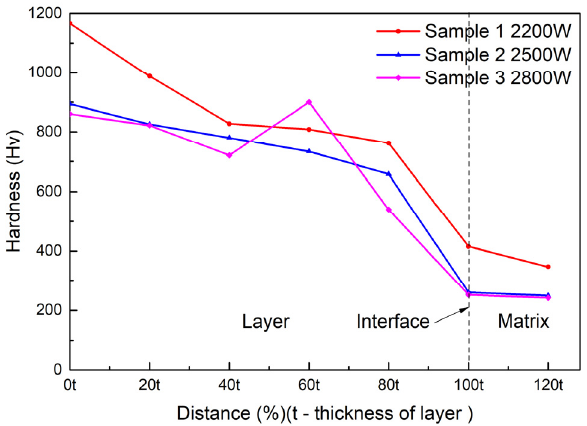
Figure 9. Vickers hardness of the cermet coatings at various laser powers.